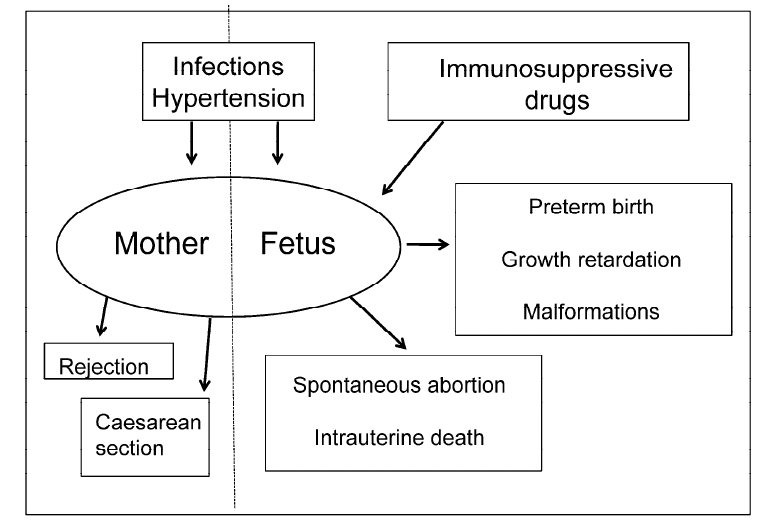
Figure 2. Risks of pregnancy in transplant recipients for mother and child. Several monocenter and national registries have highlighted the higher rate of delivery complications. Piccoli et al. [106] compared 189 kidney transplant pregnancies with